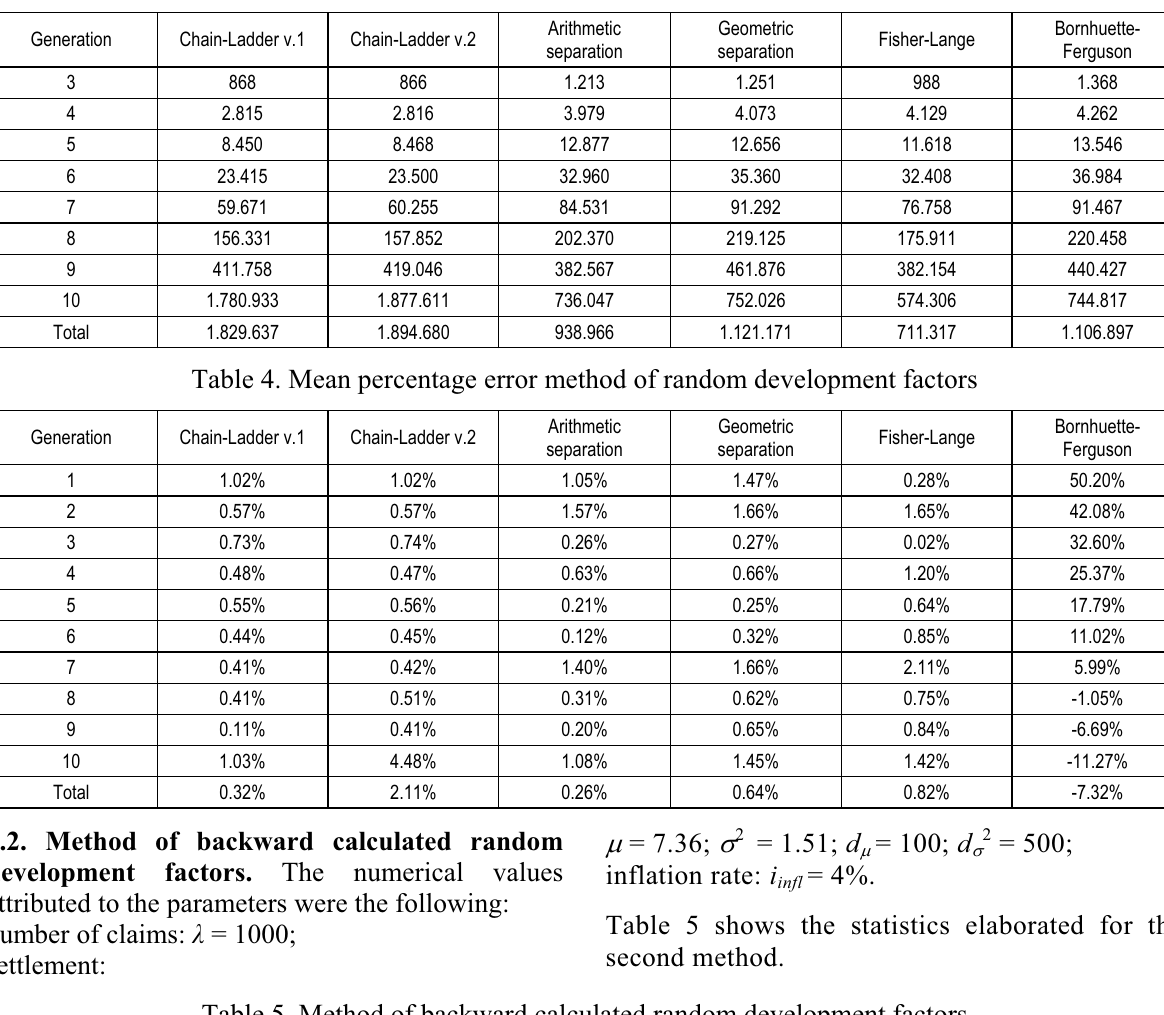
Table 3 (cont.). Mean square error method of random development factors